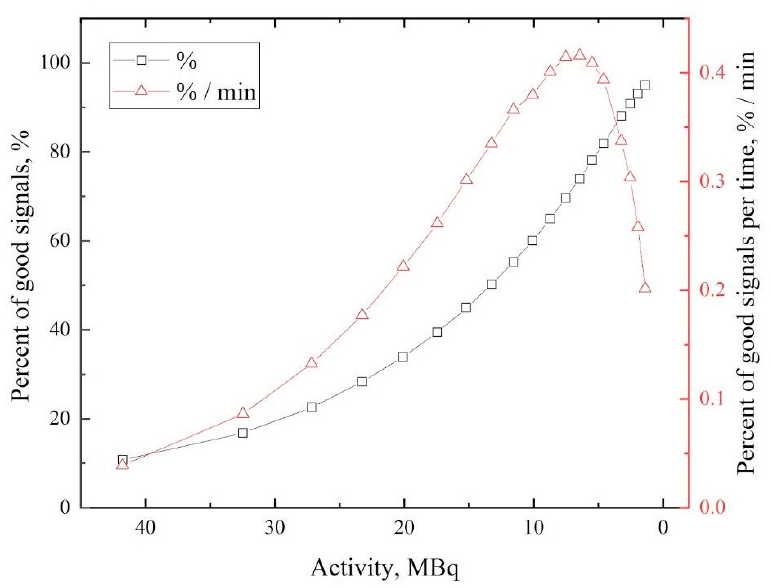
Figure 2. Dependence of “good” signals percentage (absolute and related to time values) on the 64 Cu activity.